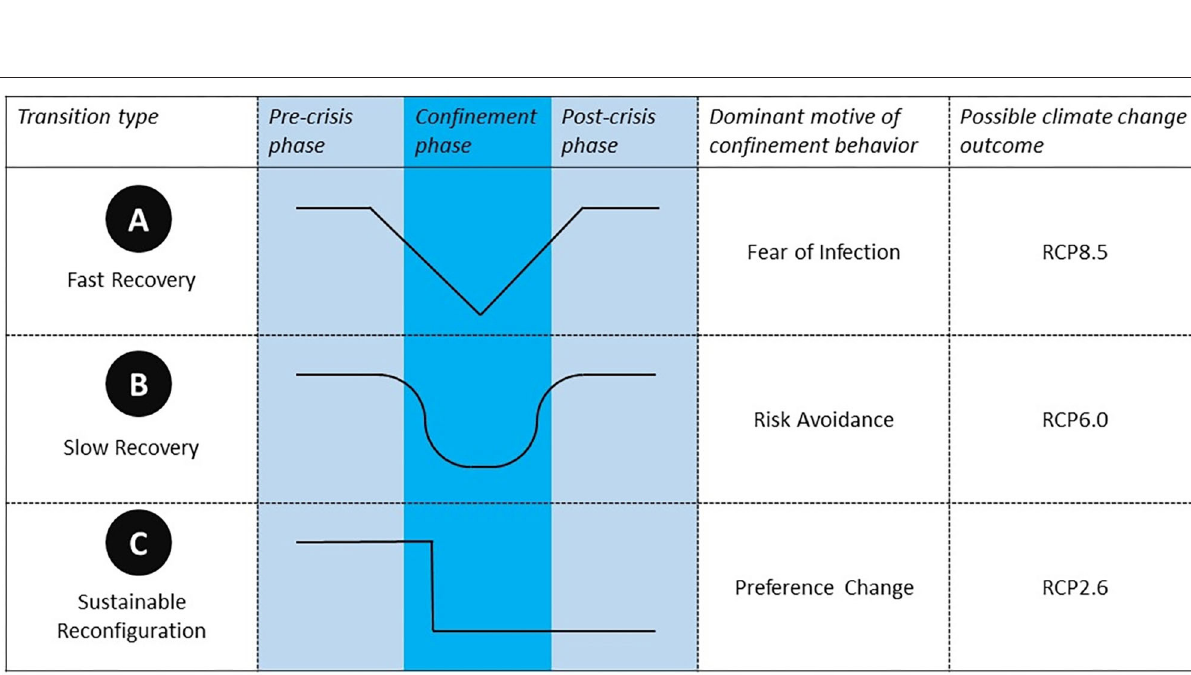
Frontiers in Sustainability |